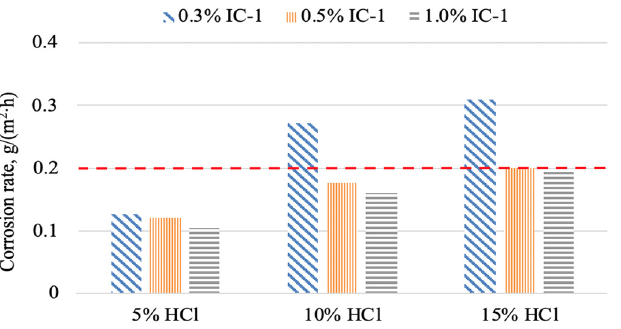
Figure 2. Corrosion rate of steel St3 in aqueous solutions of HCl of various concentrations with the addition of corrosion inhibitor IC-1, τ = 24 h, t = 20 °C.